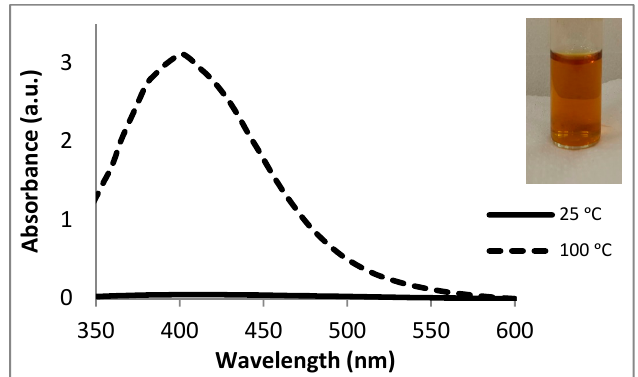
Figure 4. UV-Vis absorption spectra (in water) for the Fv-AgNPs after 18 h at room temperature (in water), and after 15 min at 100 °C. Inset: Photograph of the colour of the solution after 15 min (in water).